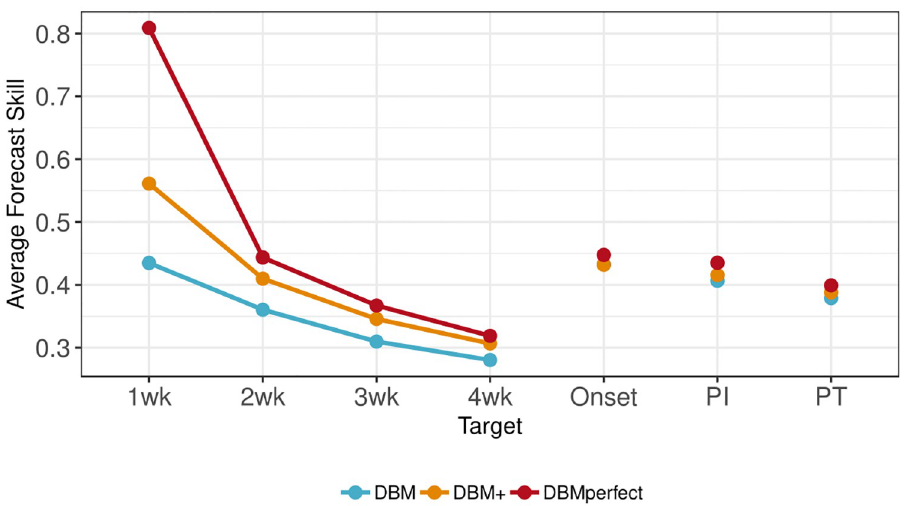
Fig 7. Target-specific average forecast skill ( s ) averaged across all regions, seasons, and weeks. DBMperfect m ,.,., τ ,. has the best forecast skill for all short-term forecasts, followed by DBM+, and finally DBM, respectively. The largest improvement in forecast skill relative to DBM occurs for one-week-ahead forecasts (i.e., nowcasts), as expected, as DBMperfect has perfect knowledge of nowcasts (but s DBMperfect,.,., τ ,. 6¼ 1 because of backfill), while DBM+ has an external estimate of the nowcast. All models exhibit similar forecast skills for seasonal targets (i.e., onset, PI, and PT), with a slight improvement for DBMperfect over DBM for all three seasonal